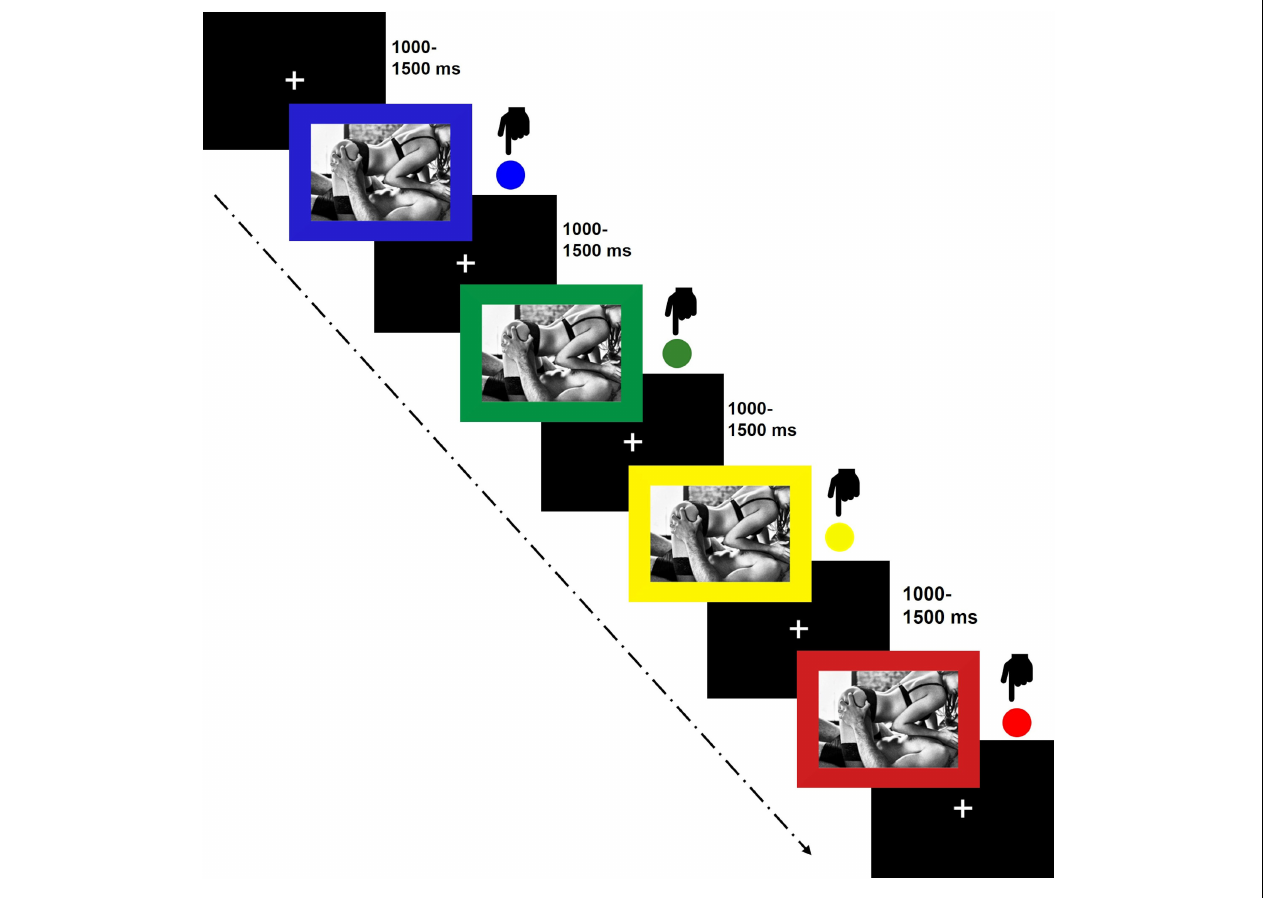
FIGURE 2 | Emotional Picture Stroop Paradigm (EPSP). TABLE 1 | Participant characteristics of naturally cycling (NC) women and oral contraceptive (OC)